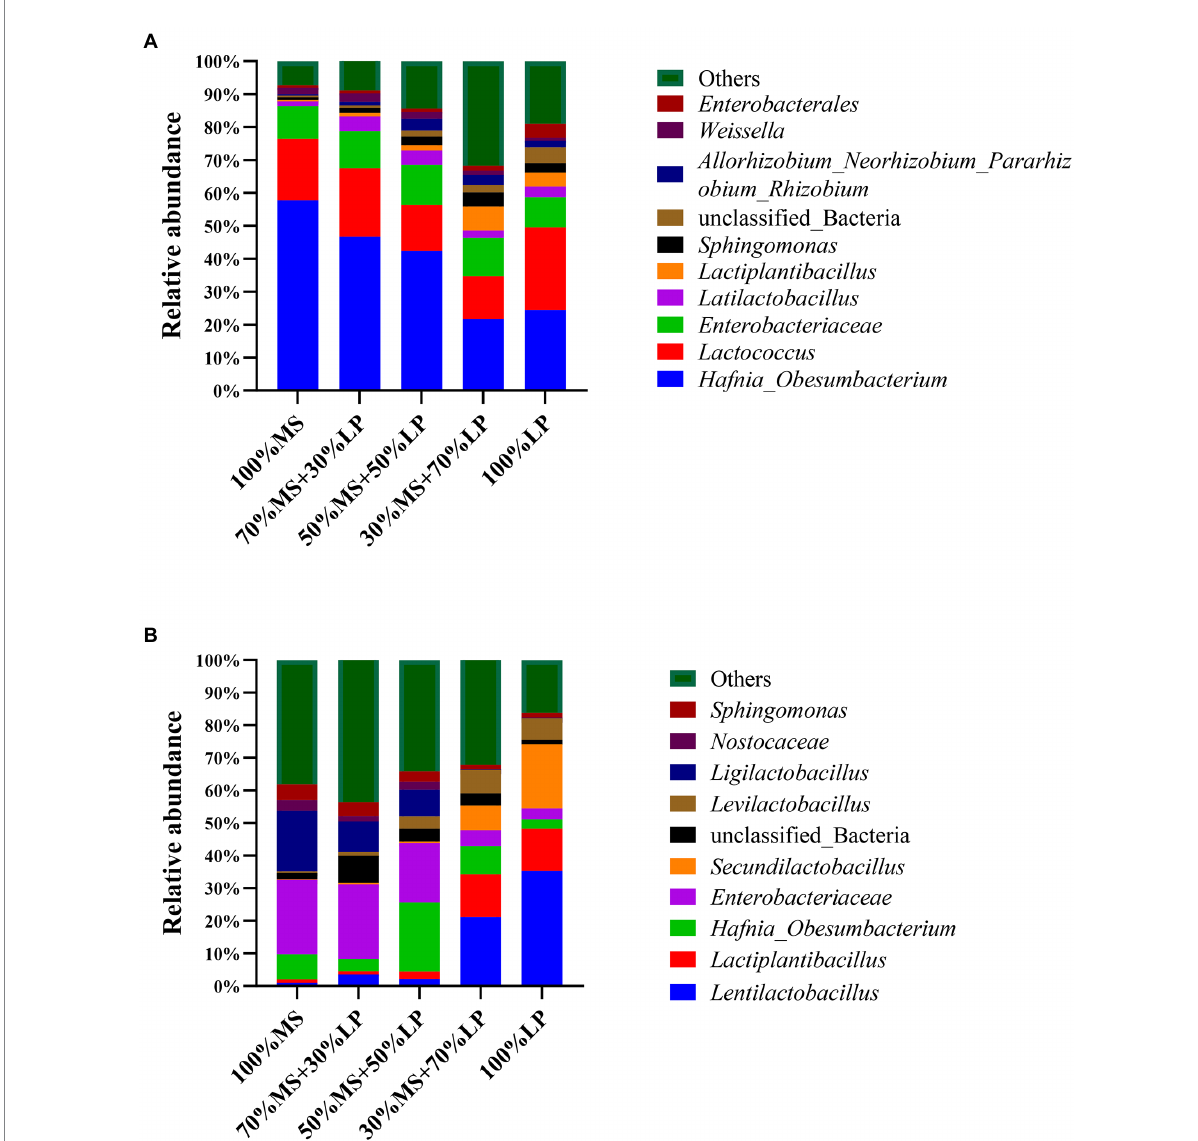
FIGURE 1 The relative abundance of bacterial communities at the genus level of alfalfa (MS) ensiled with perennial ryegrass (LP) silage for 7 (A) and 45 (B) days. 100% MS, 100% alfalfa; 70 MS + 30% LP, 70% alfalfa+30% perennial ryegrass; 50% MS + 50% LP, 50% alfalfa+50% perennial ryegrass; 30% MS + 70% LP, 30% alfalfa+70% perennial ryegrass; 100% LP, 100% perennial